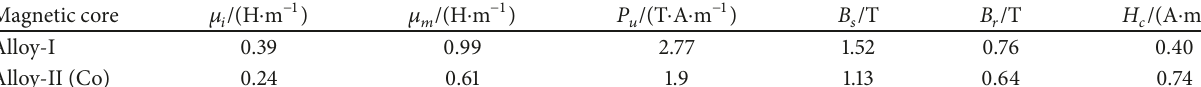
Table 1: DC soft magnetic properties of the amorphous/nanocrystalline cores heat treatment at 550 ∘ C. Magnetic core